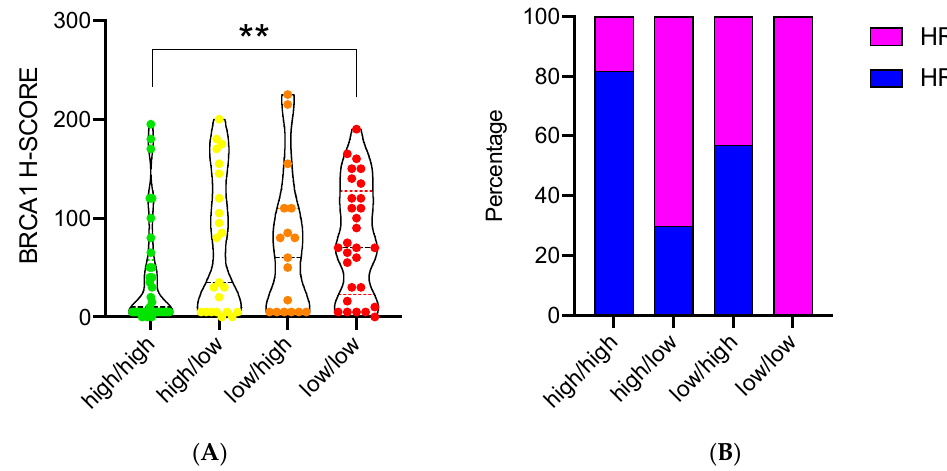
Figure 4. Association of AKT isoform categories with BRCA1 IHC expression and homologous recombination system (HR) status. ( A ) Violin plots representing the expression of BRCA1 (measured by the H-score method) among the four AKT categories; ( B ) bar chart showing the distribution of cases with proficient (HRP) and deficient (HRD) homologous recombination system among the four AKT categories. ** indicates statistical